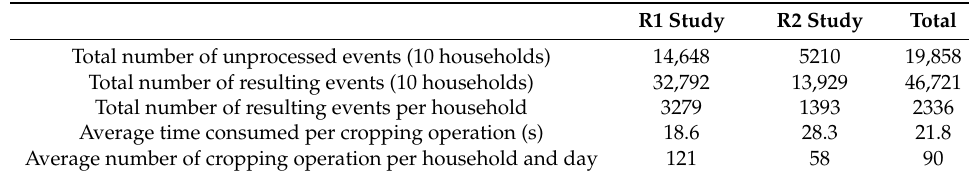
Table 1. General statistics about performance of separation process.